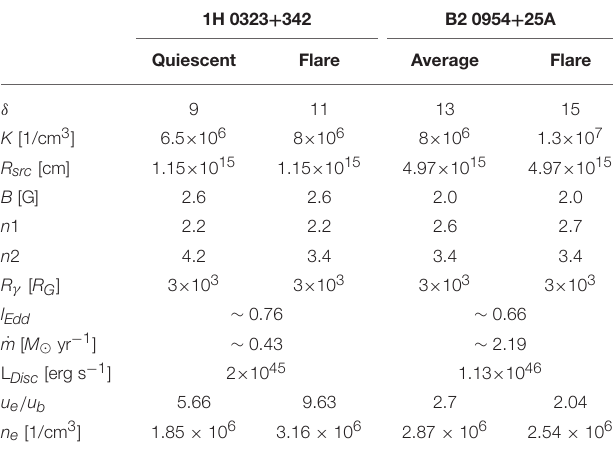
TABLE 1 | Model parameters for 1H 0323 + 342 and B2 0954 +